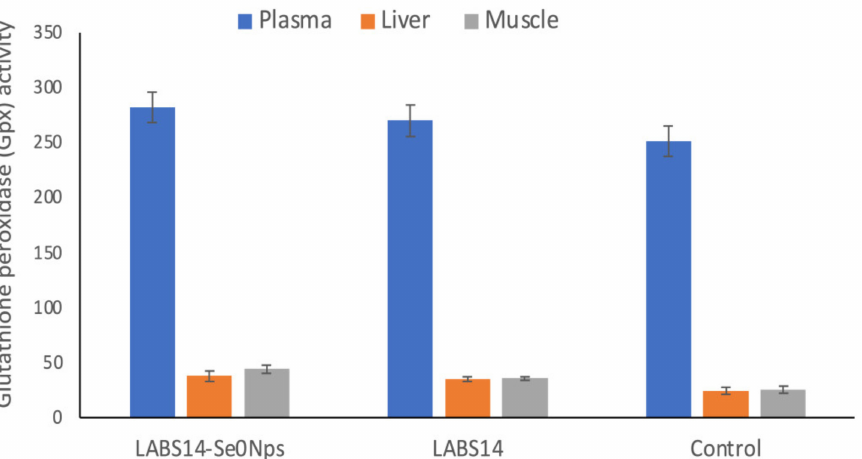
Figure 5. Glutathione peroxidase (mU mg − 1 protein) activity in rainbow trout whose food was supplemented, for 30 days, with 10 8 CFU of Se nanoparticle-enriched Lactiplantibacillus plantarum S14 strain (LABS14-Se 0 Nps) g − 1 or 10 8 CFU L. plantarum S14 strain (LABS14) g − 1 . Control did not receive the bacterial strain. Bars indicate standard